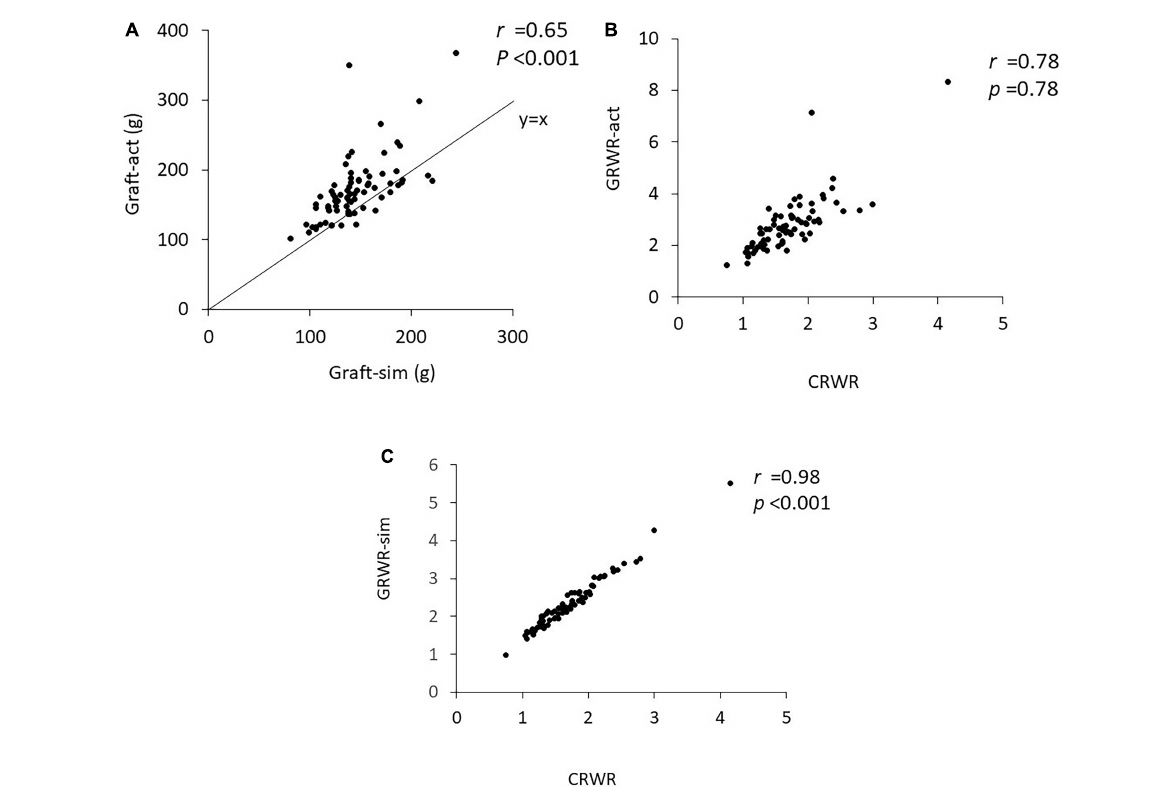
FIGURE1 Correlation coefficient between Graft-sim and Graft-act and between CRWR and GRWR-act and GRWR-sim. (A) Correlation between Graft-sim and Graft-act. (B) Correlation between CRWR and GRWR-act. (C) Correlation between CRWR and GRWR-sim.